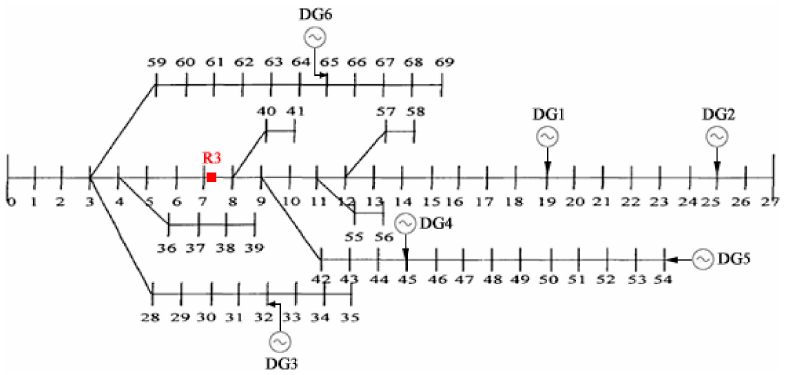
Figure 6. Structure of IEEE 69-node distribution system.